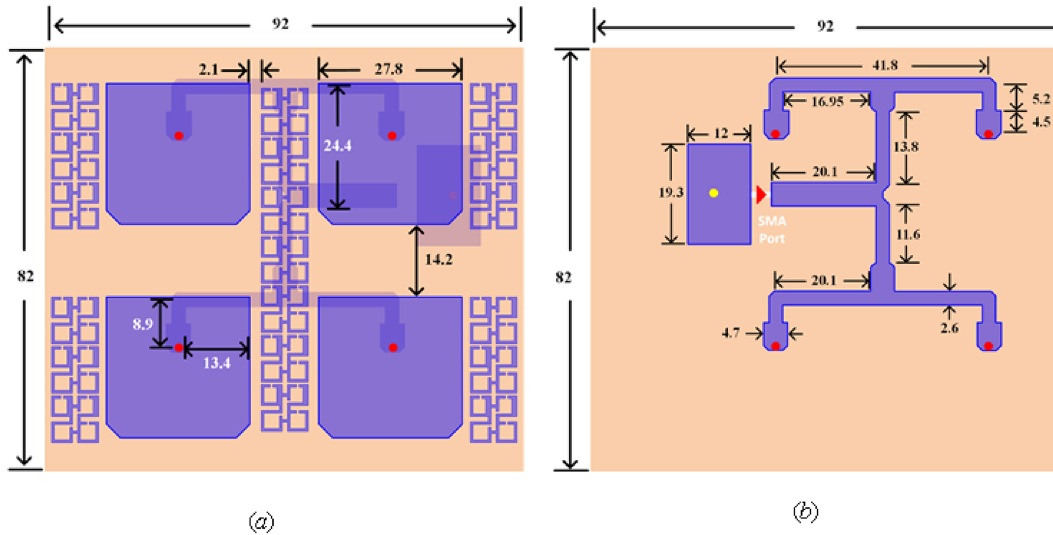
Figure 9. Single port (subarray), ( a ) top layer with 2 × 2 patches, ( b ) bottom layer with feeding network (all dimensions are in mm).